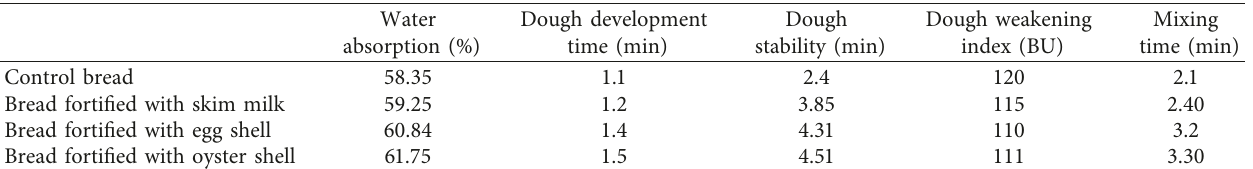
Table 2: Farinograph parameters of the dough behaviour of the control bread and breads fortified with skim milk and egg shell and oyster shell